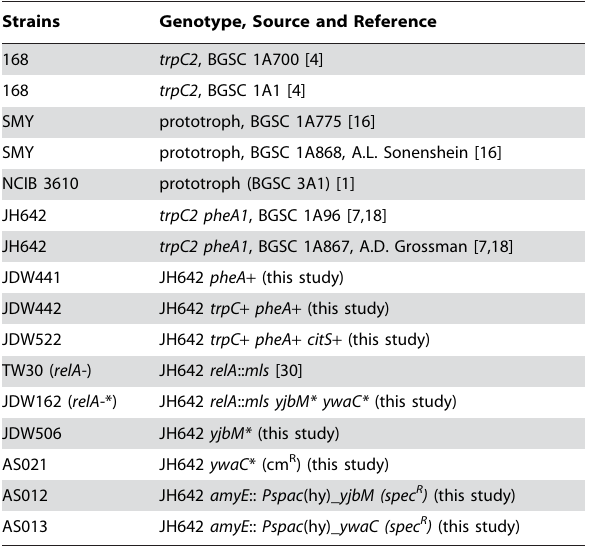
Table 2. B. subtilis strains